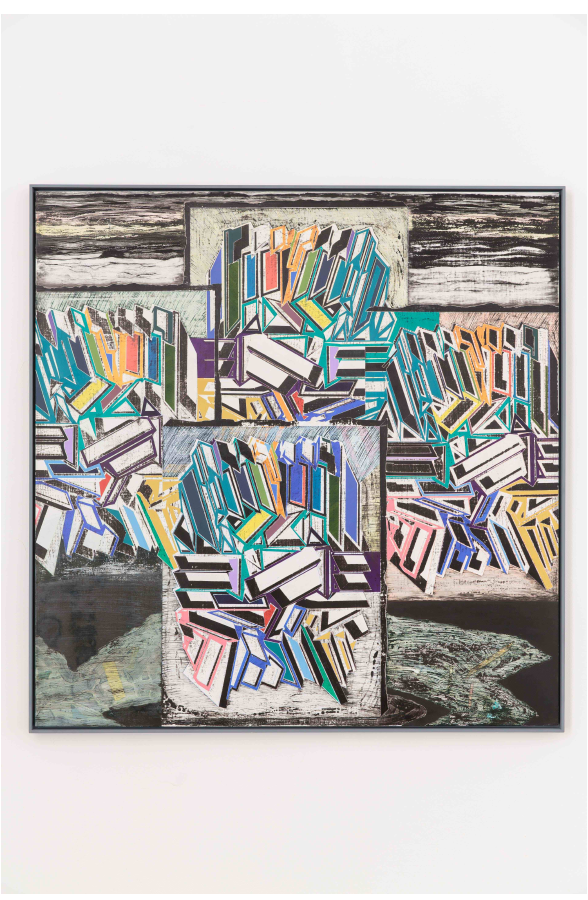
Figure 3: Ben Jenner, B[3F+1R] in landscape , 2016, Pencil, gesso, acrylic paint on wood. 151 x